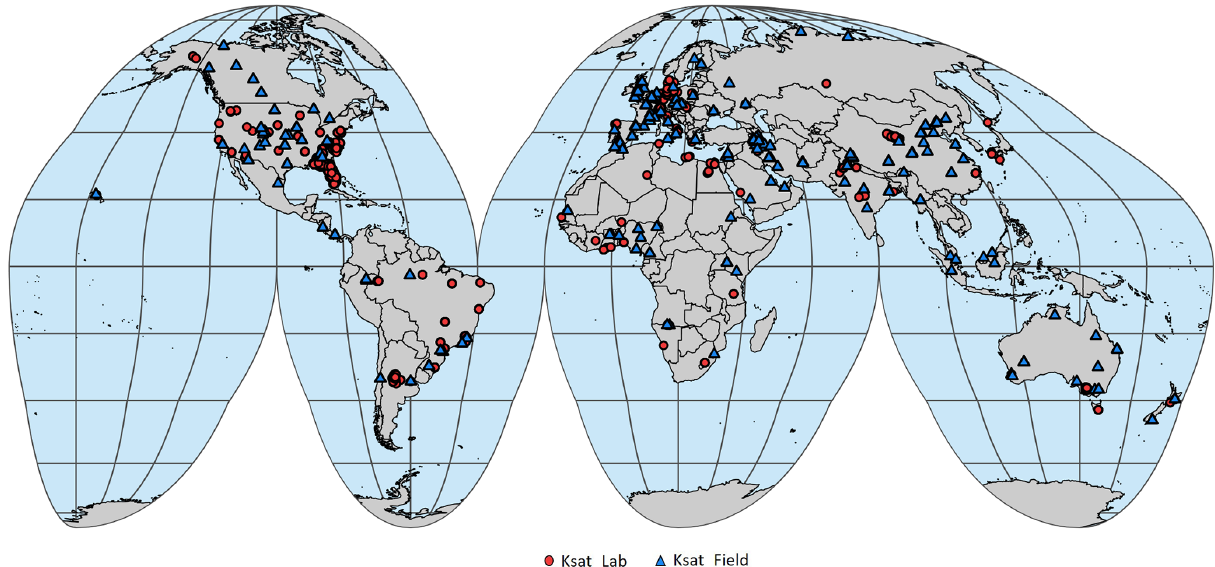
Figure 1. Spatial distribution of K sat measurements based on (red) laboratory and (blue) field measurements in the SoilKsatDB. A total of 1908 locations are shown on the